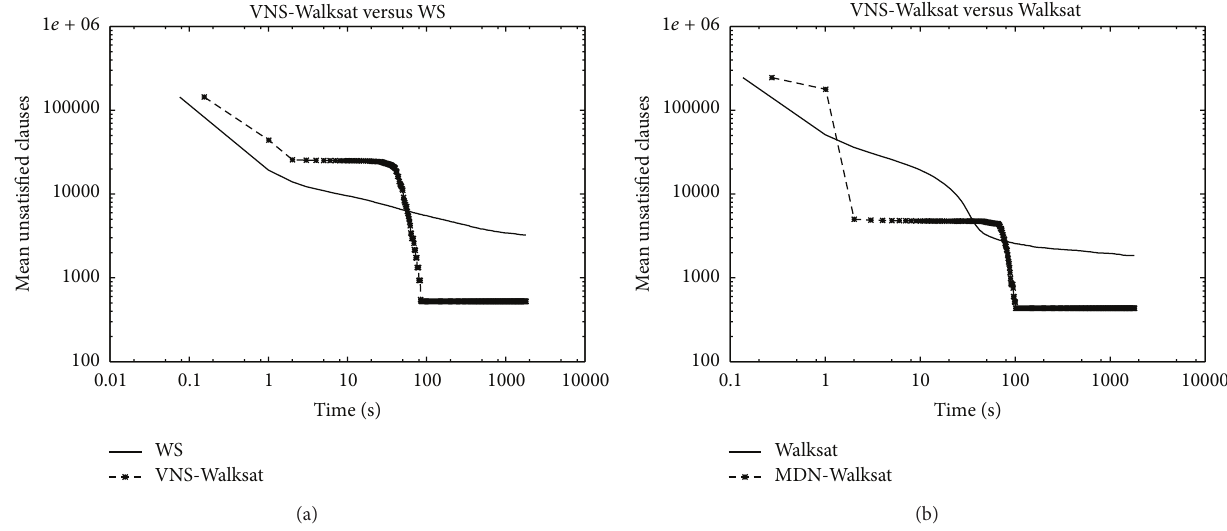
Figure 4: Log-Log Plot: (a) rsdecoder1-blackbox-CSEEblock-problem.dimacs-32.filtered: variables = 277950, clauses = 806460, (b) rsdecoder-multivec1.dimacs.filtered: variables = 394446, clauses = 1626312. Time development for 100 runs in 15